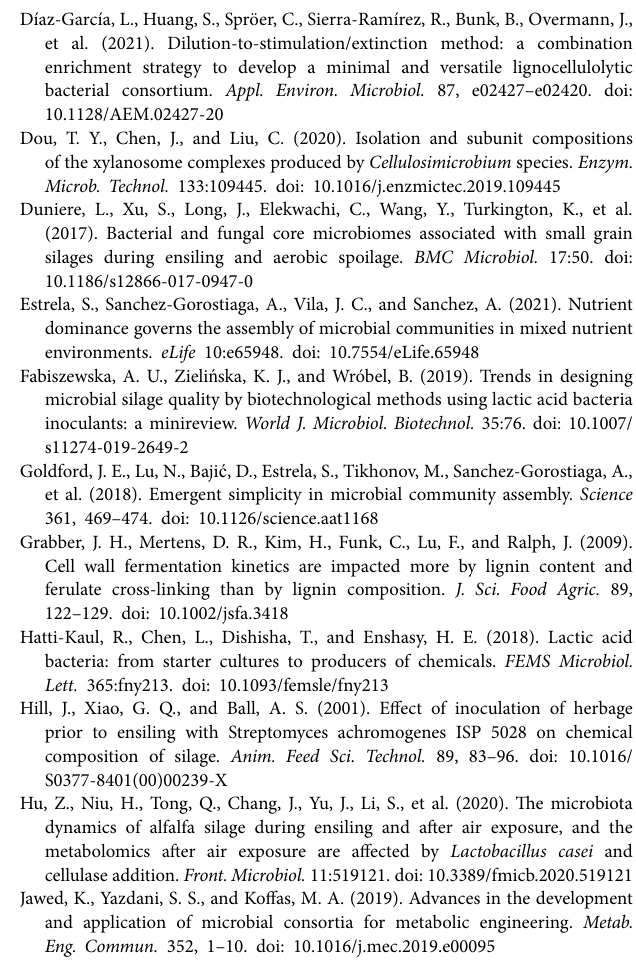
Supplementary Figure S1 | Relative proportion (%) of the most common lactic acid bacteria (LAB) found in silage processes. Metagenomic sequence taxonomic assignment was carried out by using RefSeq database. Supplementary Figure S2 | Secreted endo-enzymatic activities (OD values) on (A) six chromogenic polysaccharide hydrogels (CPH) and (B) two insoluble biomass substrates (ICB) after T10 consortium growth on unmodified pH 6.2, pH 5, and pH 4. Supplementary Figure S3 | Relative proportion (16S rRNA data) of taxa (class) after incubation of the consortium at T10 in a range of pH values. Error bars represent SDs from three biological replicates. Supplementary Table S1 | Detailed features of metagenome assembled genomes (MAGs) reconstructed from T2, T10, and S consortia. Supplementary Table S2 | Number of genes involved in lactic acid